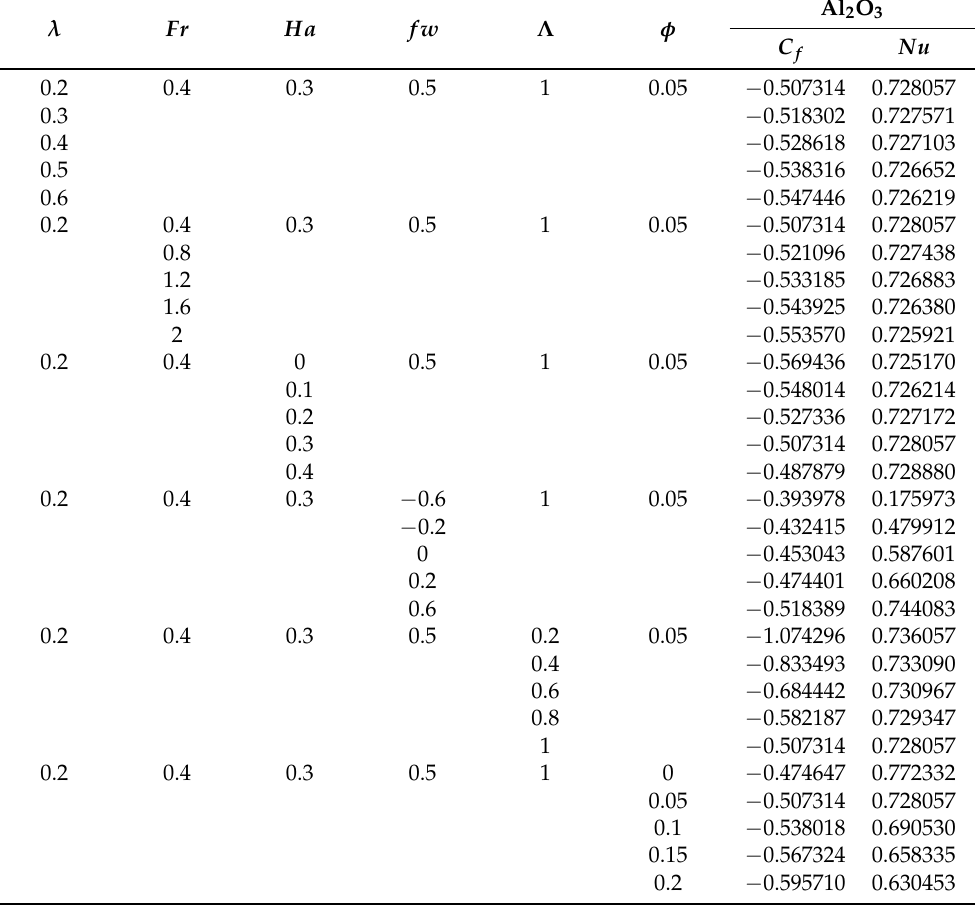
Table 5. SFC & LNN comparison for a diverse combination of λ , Fr , Ha , fw , Λ , φ